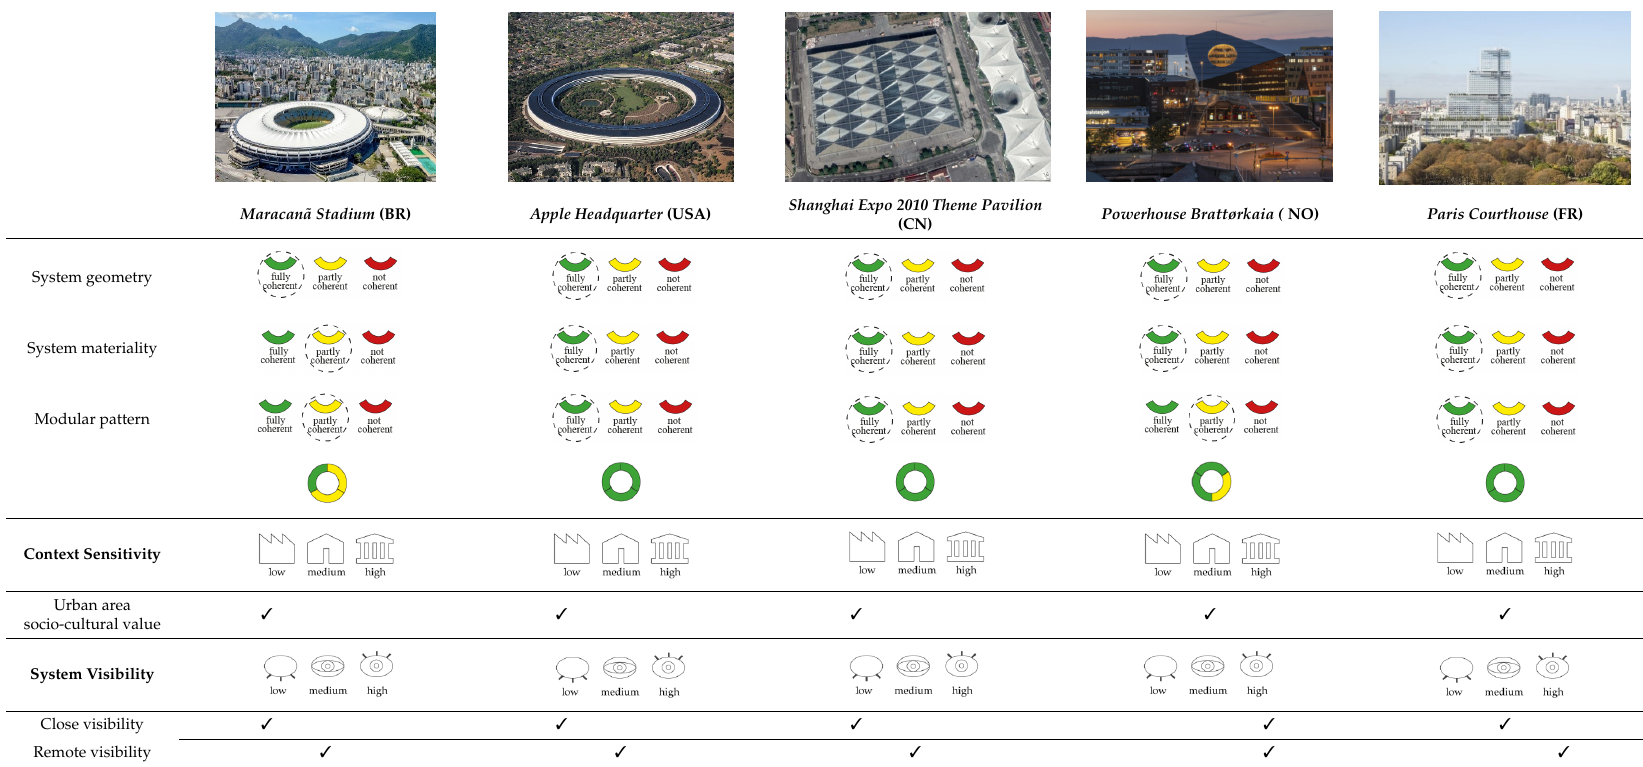
Table 4. Architectural integration quality, context sensitivity and system visibility of the landmark buildings (first part).